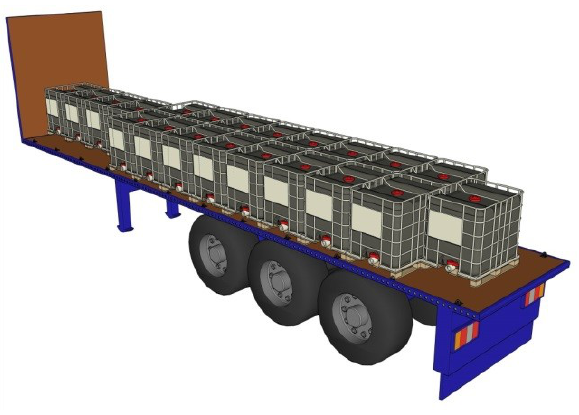
Figure 6: Proposal for load distribution of 21 IBC containers in the case of the semitrailer with payload of 24 t [3]